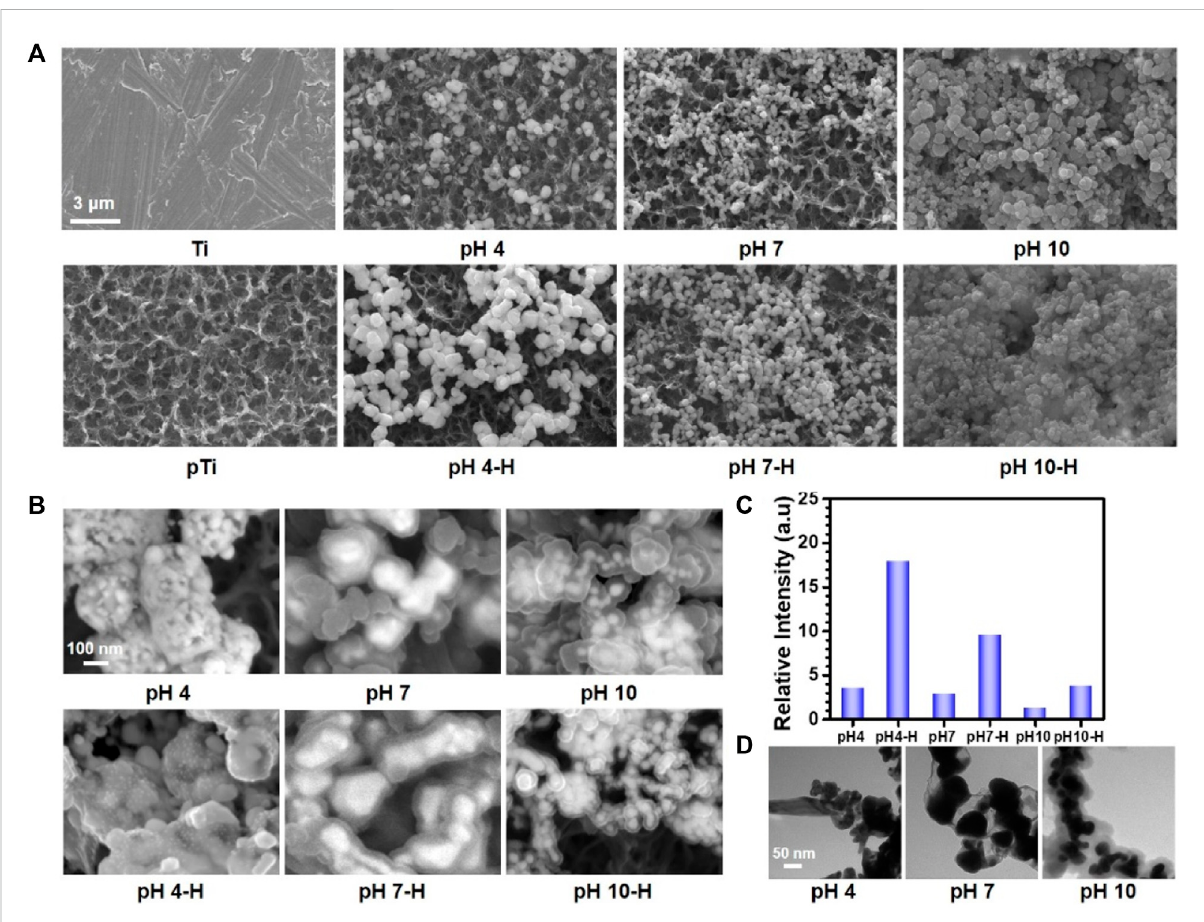
FIGURE 1 The surface morphology of different samples: (A) scanning electron microscopy (SEM) images of different samples; (B) Backscattered electron (BSE) images of different samples; (C) relative intensive of Ag by X-ray photoelectron spectroscopy (XPS); (D) Transmission electron microscope (TEM) analysis of AgNPs in solutions at pH 4, pH7,